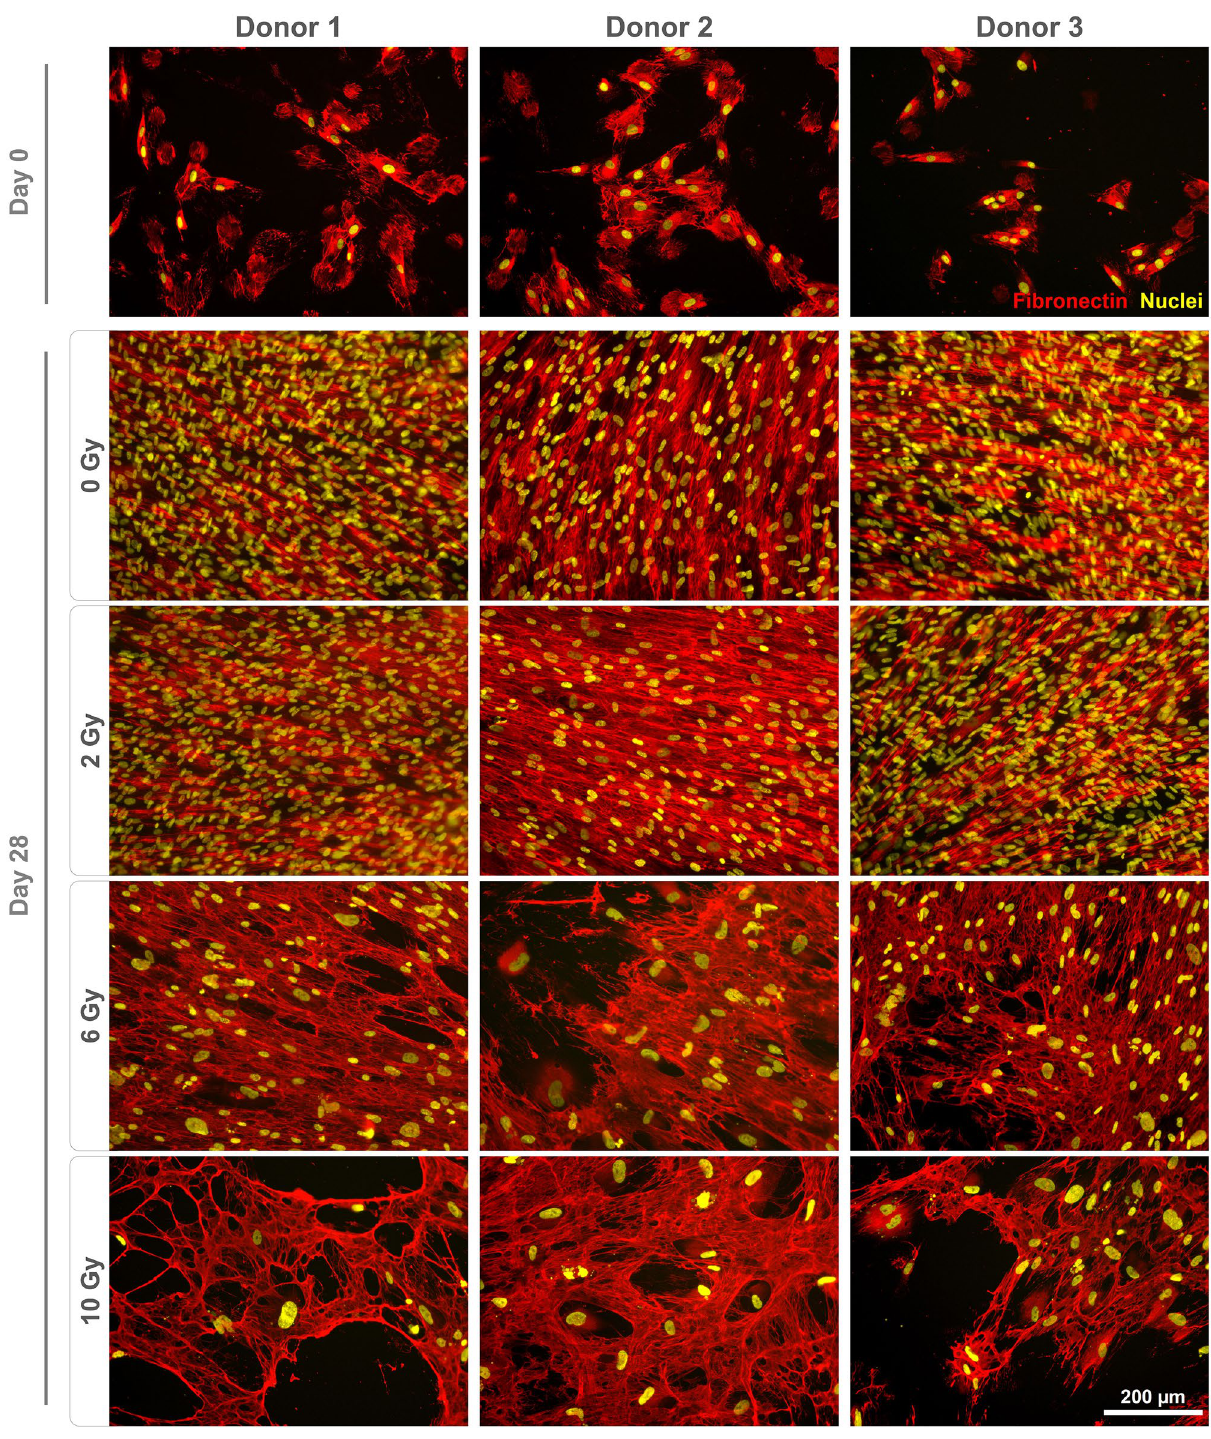
Figure 3. Immunostaining of irradiated JHOBs for fibronectin. Cells were irradiated with 2, 6 and 10 Gy or sham, and stained for expression of fibronectin (red) after 28 days of cultivation in osteogenic medium. Non- treated cells on day 0 were used as a control. Nuclei were counterstained with DAPI (Fig. 4), ALPL, osteopontin (Fig. 5) and osteonectin (Supplementary Fig. S2) was demonstrated for all condi- tions, with no discernible changes of the staining patterns besides the enlargement of the cells. Collagen I was found to be expressed in the cytoplasm on day 0, while extensive staining of the well was found for 0 and 2 Gy conditions (except for donor 2). A less homogenous deposition of collagen I was visible in 6 and 10 Gy condi- tions (all donors), and also in the 2 Gy condition of donor 2 (Fig. 6). No unspecific staining of secondary anti- bodies was detected (Supplementary Fig. S3).